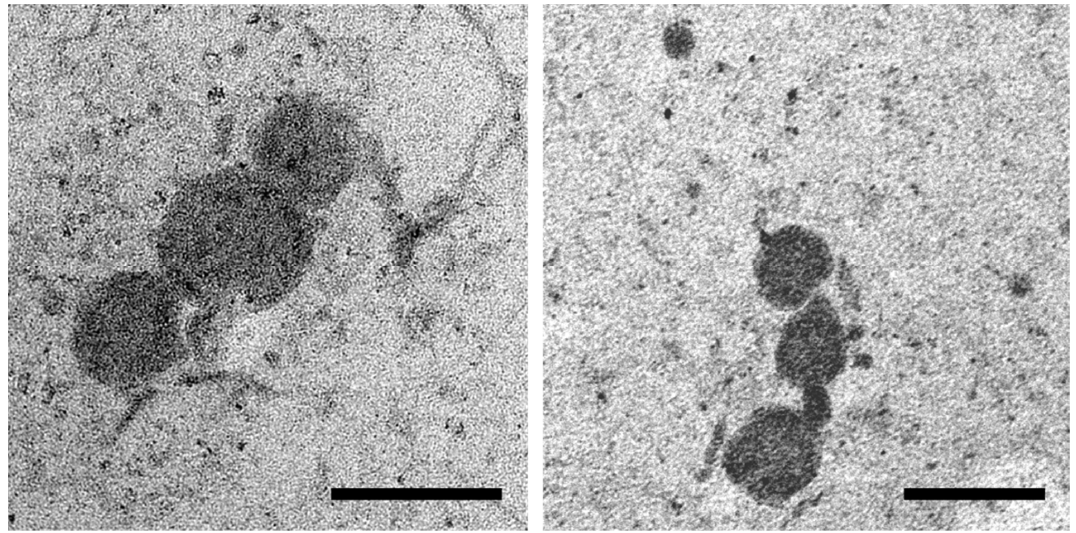
Figure 1. Representative transmission electron microscopy (TEM) images of OMVs isolated from S. Infantis culture. Scale bar 200 nm.